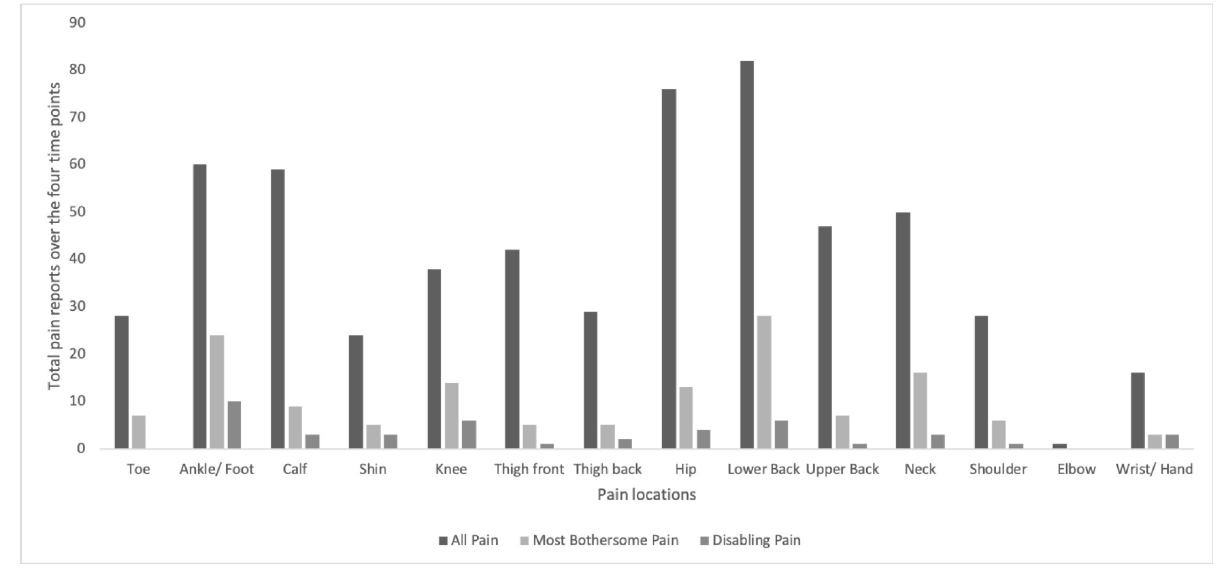
Fig 3. Frequency of pain reports by pain